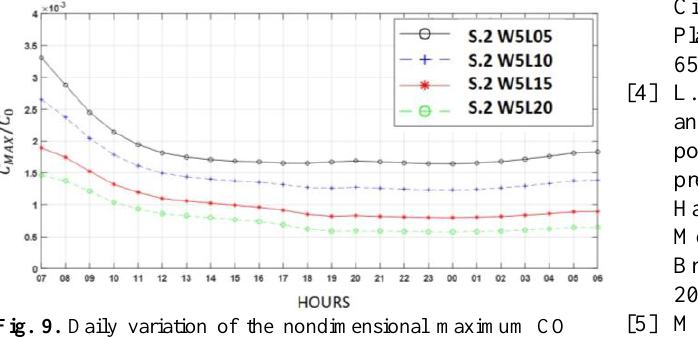
Fig. 9. Daily variation of the nondimensional maximum CO concentration C MAX /C 0 inside the street 2, for the different simulated courtyard dimensions.